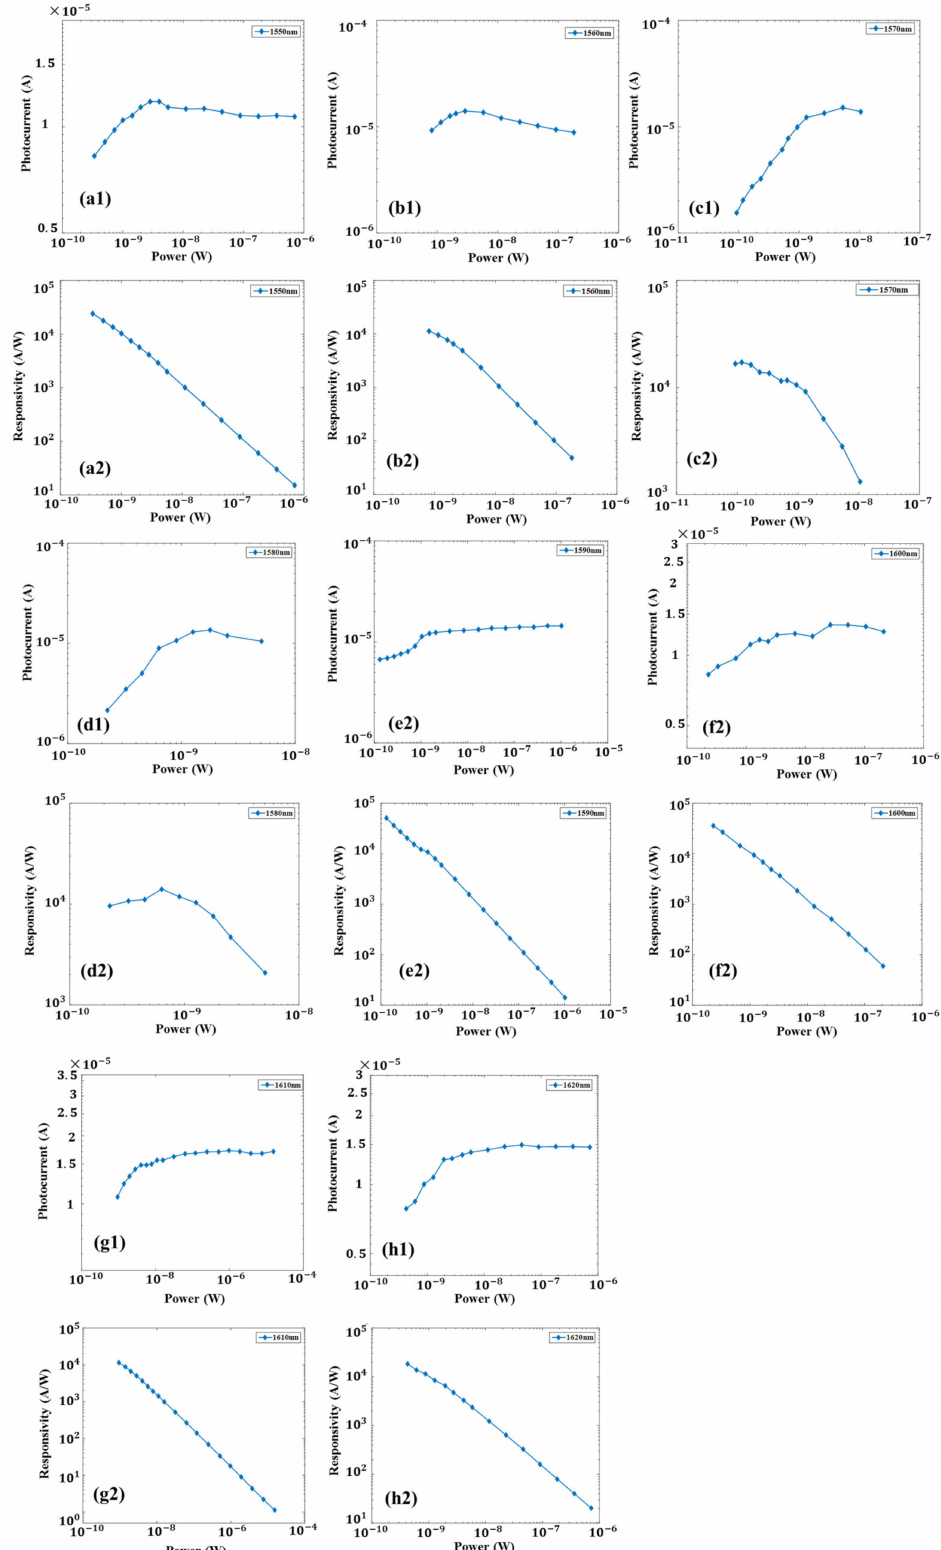
Figure A5. Photoresponse in the wavelength range of 1560–1620 nm. The dependences on incident optical power of the photocurrents ( a1 – h1 ) and responsivities ( a2 – h2 ). The wavelength interval of ( a – h ) is 10